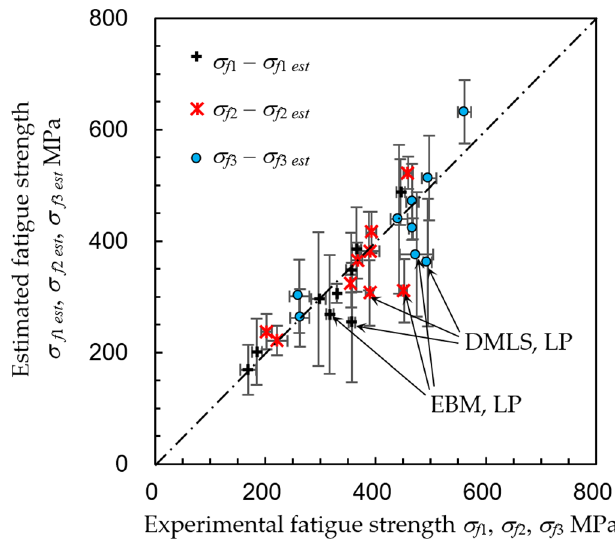
Figure 16. Relationship between the experimental fatigue strength and fatigue strength estimated from the surface roughness, surface hardness, and surface residual stress.